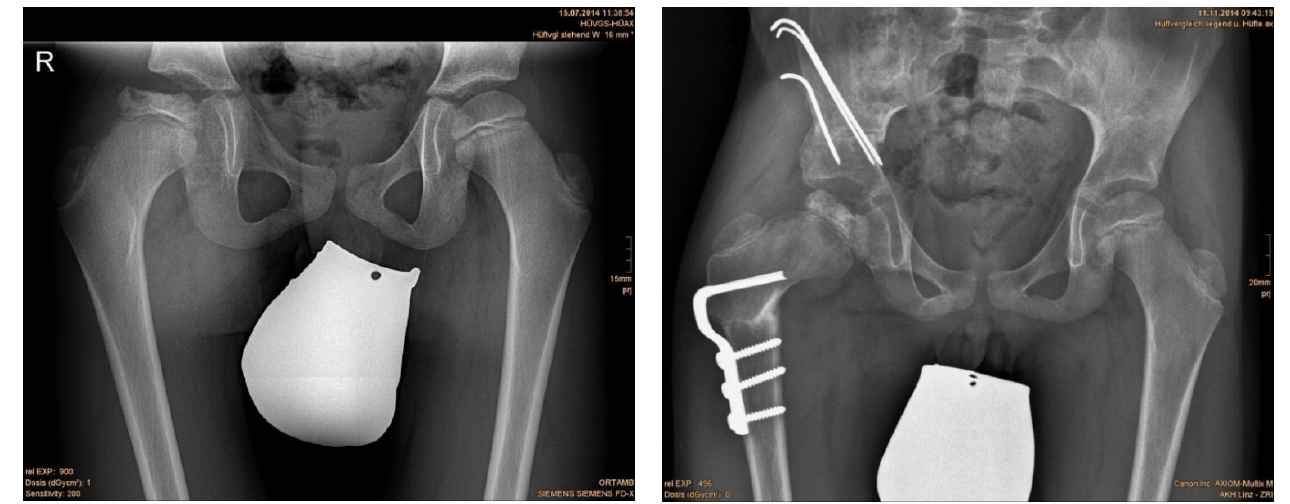
Figure 1. ( left ) Anteroposterior radiograph of a six-year-old male with NDH; ( right ) result 3 months postoperatively.